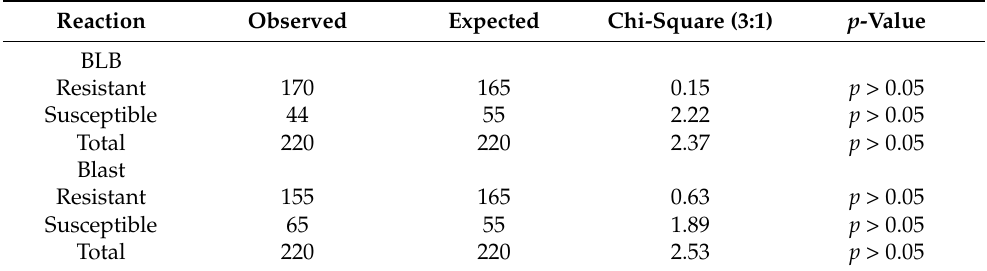
Figure 3. Phenotypic expression of the newly improved and parental lines. Note: ( A ) improved line, ( B ) recurrent parent and ( C ) parental and Improved lines. Table 5. Observed and expected segregation ratios of resistant and susceptible plants in the BC 2 F 2 generation challenged with pathotypes P7.7 and P7.2 of Xoo and Magnaporthe oryzae .